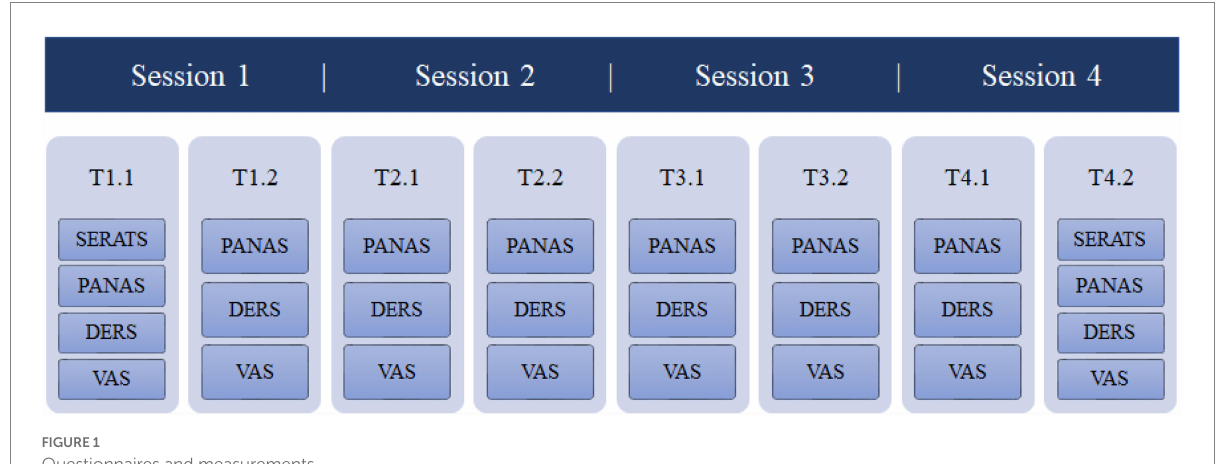
FIGURE 1 Questionnaires and